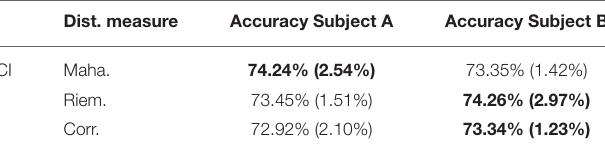
TABLE 2 | 10-fold cross-validated accuracy of our BCI system on two subjects over 10 sessions for Conceptual Imagery (CI). Dist.